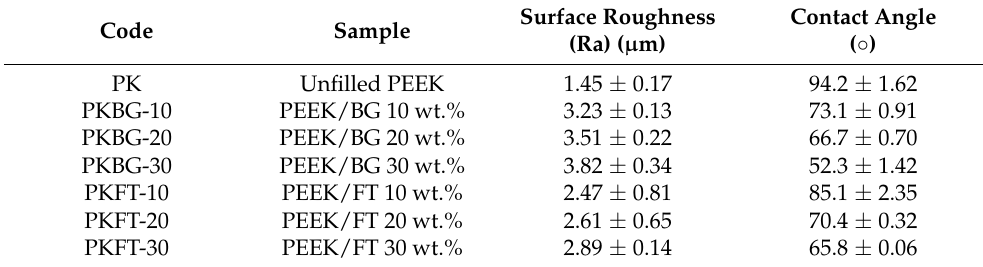
Table 2. Mean values and standard deviation n (mean ± SD) for surface roughness and contact angle data of pure PEEK together with various PEEK nanocomposites. ( n = 6, p <